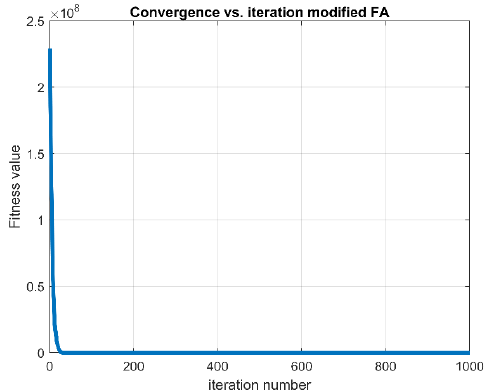
Figure 7. MFA fitness curve showing perfect convergence within 100 iterations.